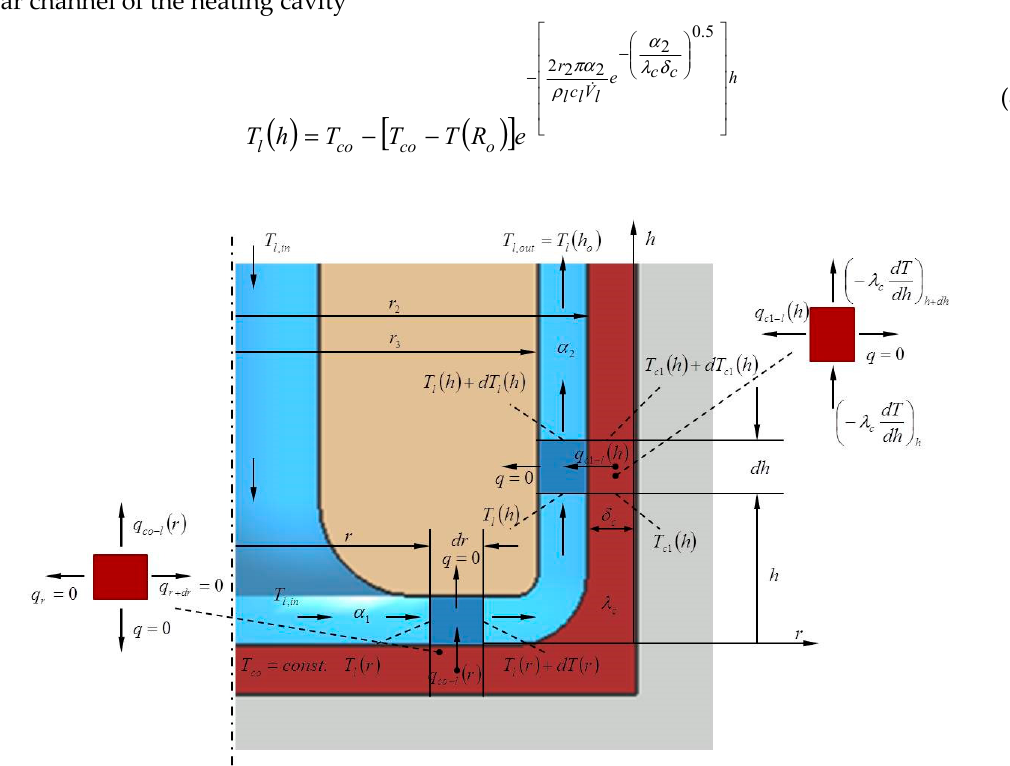
Figure 2. The thermal interaction between heated cavity and central impact